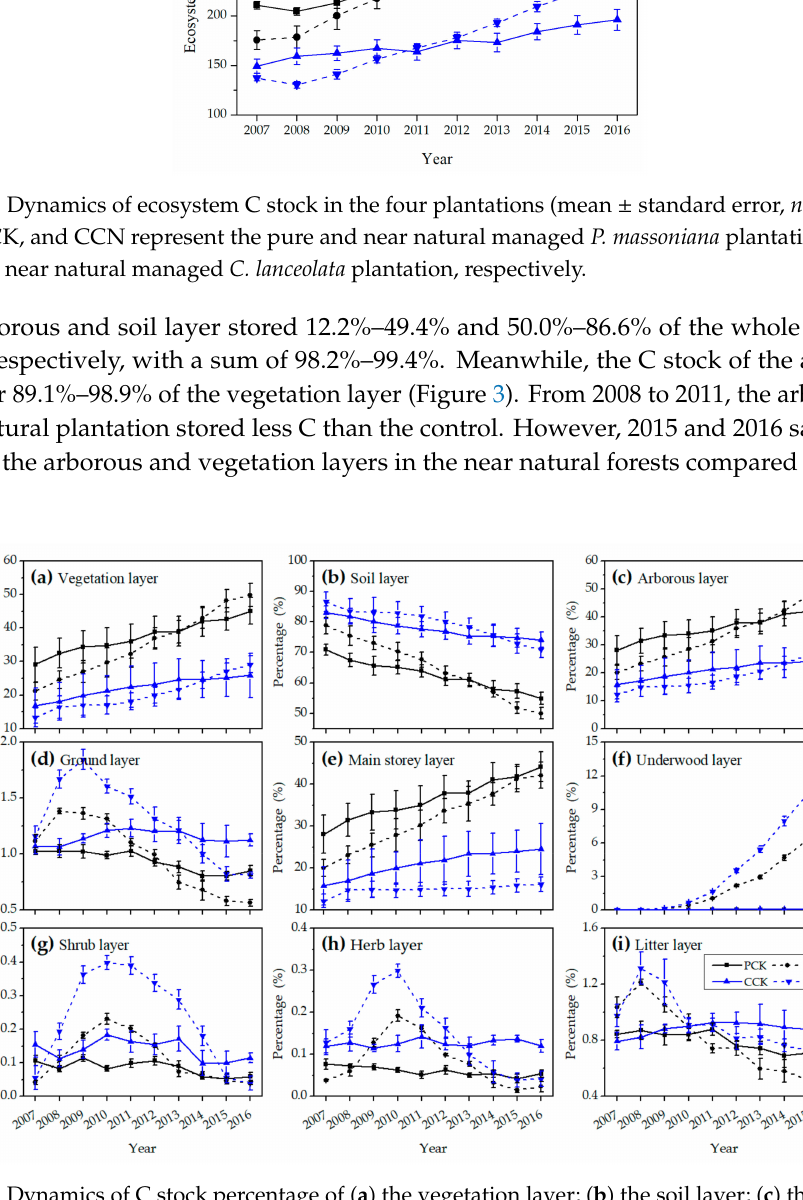
Figure 3. Dynamics of C stock percentage of ( a ) the vegetation layer; ( b ) the soil layer; ( c ) the arborous layer; ( d ) the ground layer; ( e ) the main story layer; ( f ) the underwood layer; ( g ) the shrub layer; ( h ) the herb layer; and ( i ) the litter layer in the four plantations (mean ± standard error, n = 4). PCK, PCN, CCK, and CCN represent the pure and near natural managed P. massoniana plantation and the pure and near natural managed C. lanceolata plantation, respectively. The main story layer was dominated by P. massoniana and C. lanceolata , whereas the underwood layer was dominated by the underplanted E. fordii and Q. gri ffi thii and natural regenerated